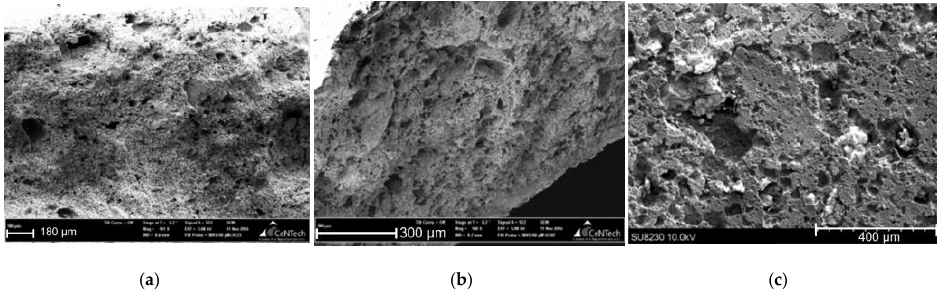
Figure 8. SEM images of fractures of composite materials ( a ) HA (90)-PLGA, ( b ) HA (75)-PLGA, ( c ) HA (50)-PLGA.